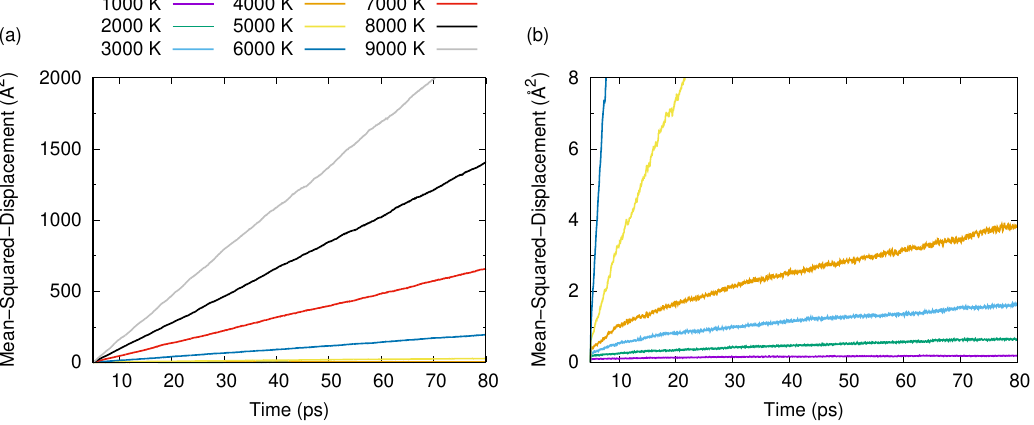
Figure 2. ( a ) Mean-squared-displacement (MSD) for various temperatures at 1.5 g/cc using the Tersoff potential. ( b ) Close-up view of data from panel ( a ), demonstrating diffusion at lower temperatures.